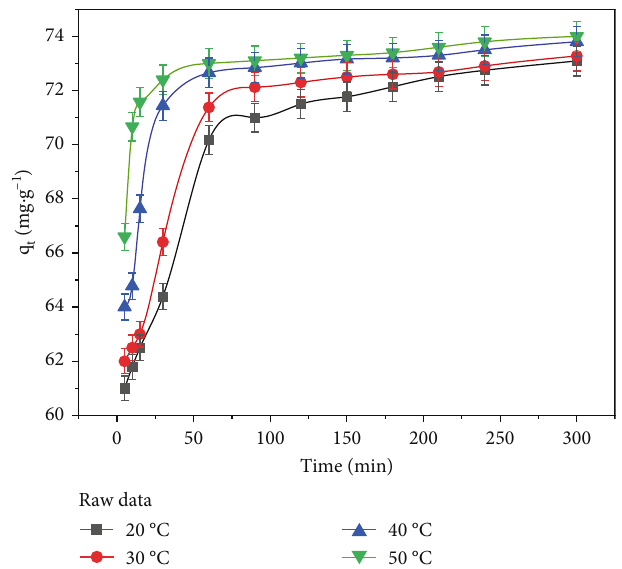
Figure 4: E ff ect of contact time on the adsorption of 150 mg · L -1 of BF dye on TKC at di ff erent temperatures.